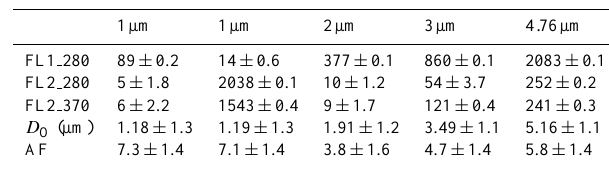
Table 2. Average modal centres of PSL measurements input to clus- ter analysis